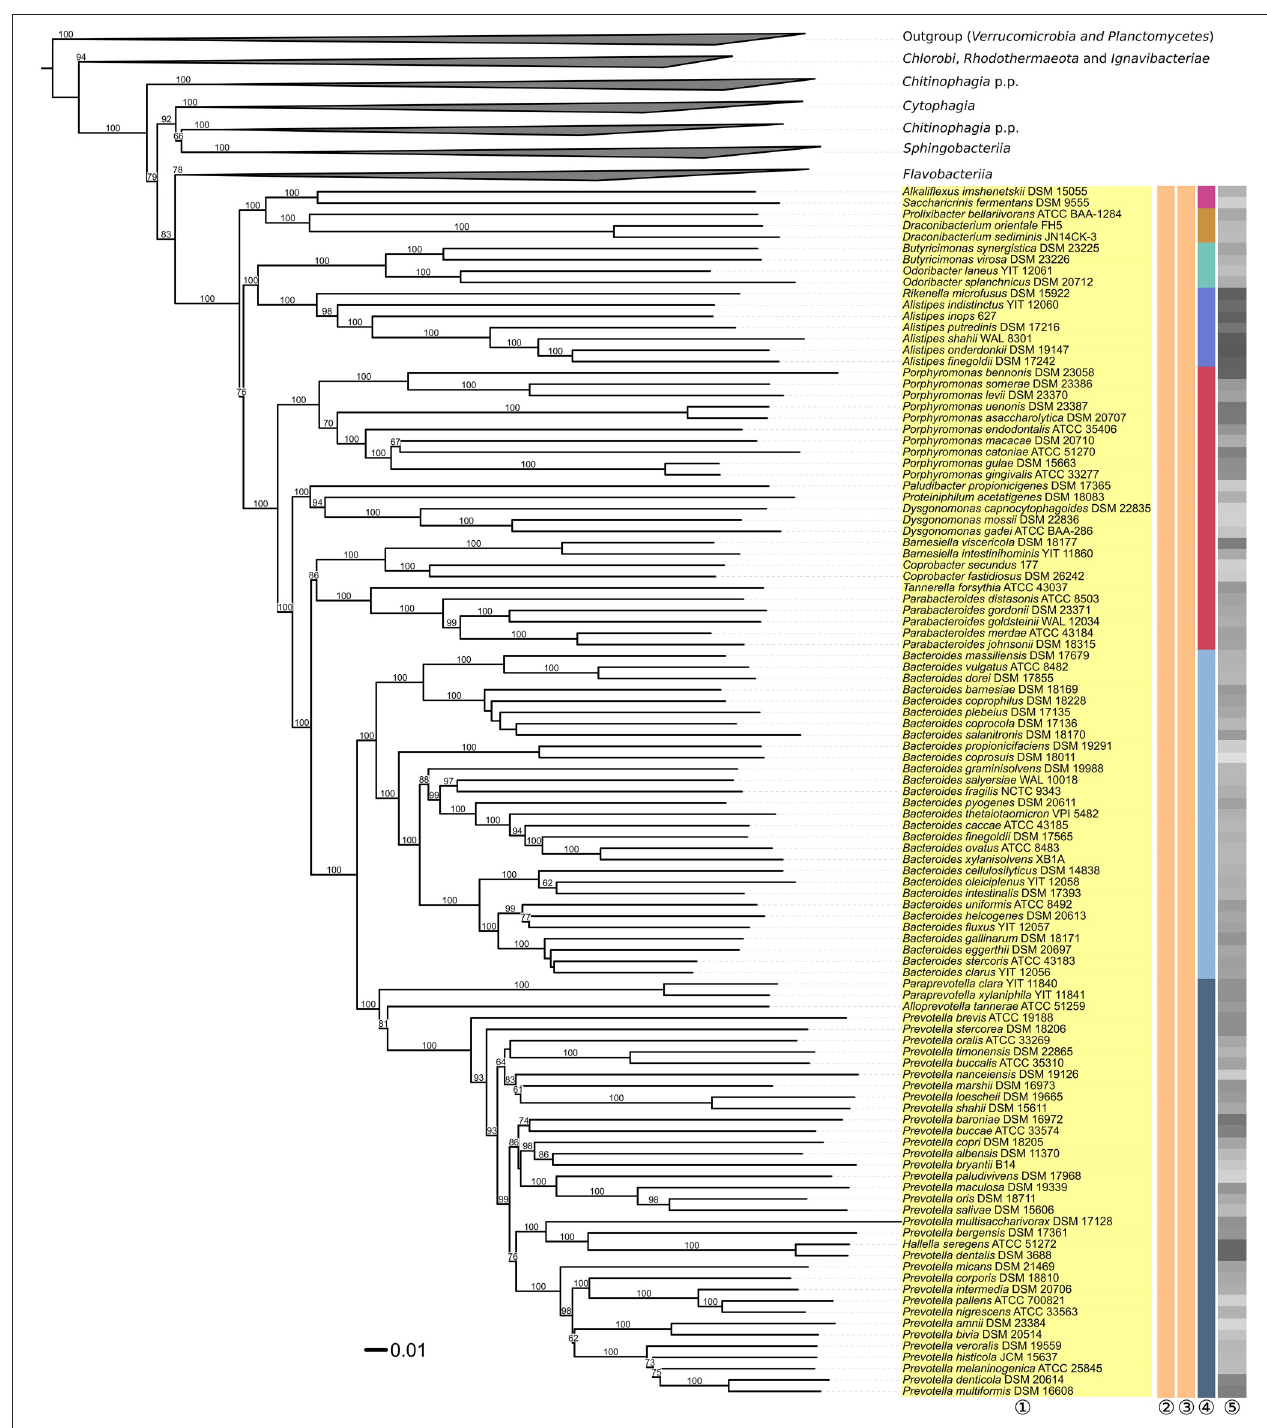
FIGURE 3 | Second part of the phylogenomic tree inferred with GBDP. Tree inferred with FastME from GBDP distances calculated from whole proteomes. The numbers above branches are GBDP pseudo-bootstrap support values from 100 replications. Tip colors indicate the phylum, colors to the right of the ingroup tips indicate, from left to right, class, order and family (see the legend embedded in Figure 2 for details). Gray scale on the very right indicates the exact G + C content as calculated from the genome sequences. The non- Bacteroidia parts of the tree, which have been collapsed here, are shown in Figures 2 , 4 .